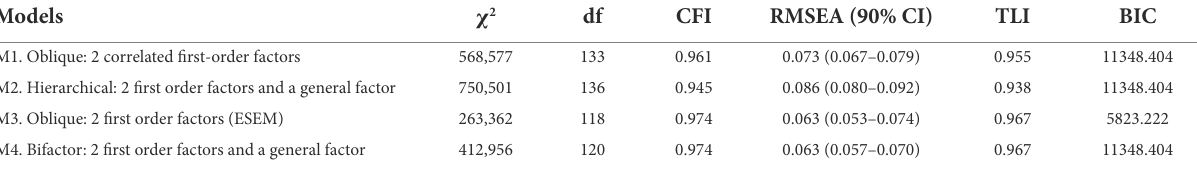
TABLE 4 Evidence fit of the factor structures in